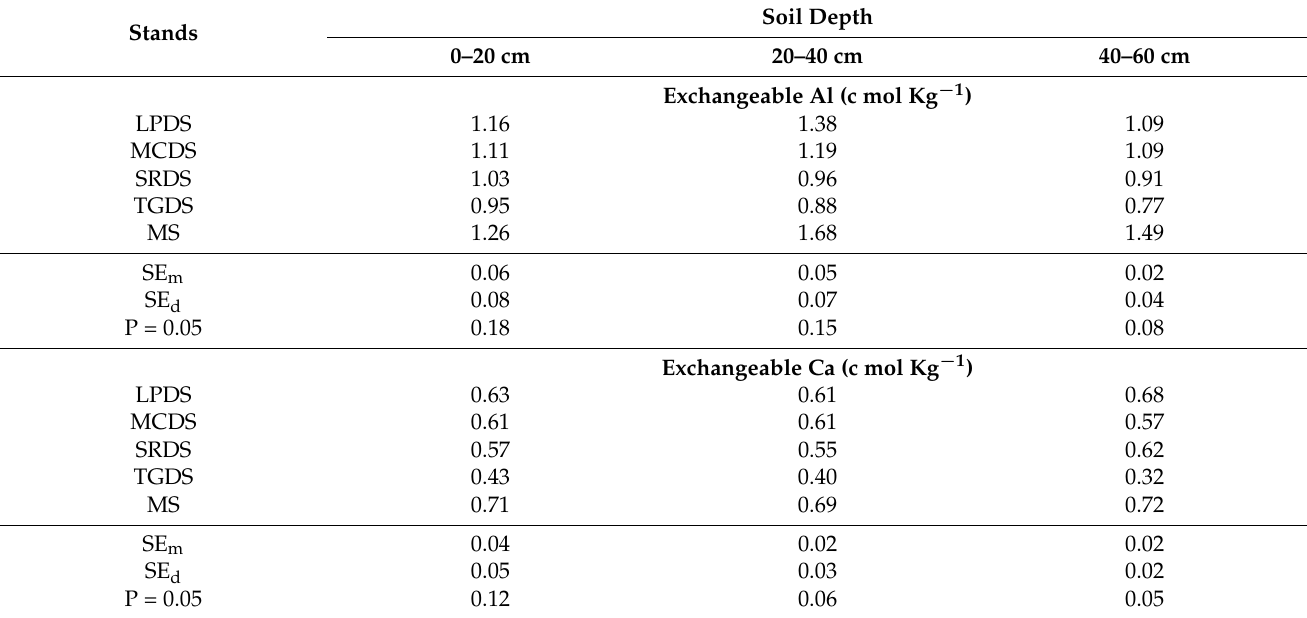
Table 5. Exchangeable ‘Al’, ‘Ca’ and ‘Mg’ in soil of different